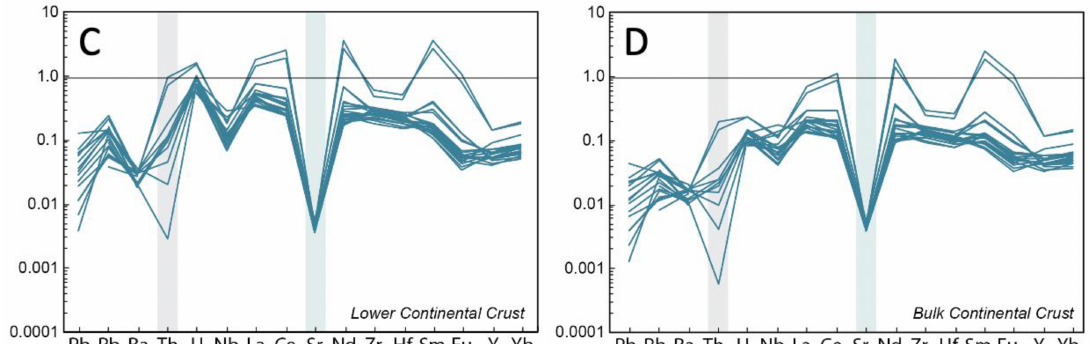
Figure 7. Normalization [37] of Kinnikinic Quartzite samples to Earth’s bulk crustal reservoirs. ( A ) Upper Continental Crust, ( B ) Middle Continental Crust, ( C ) Lower Continental Crust, ( D ) Bulk Continental